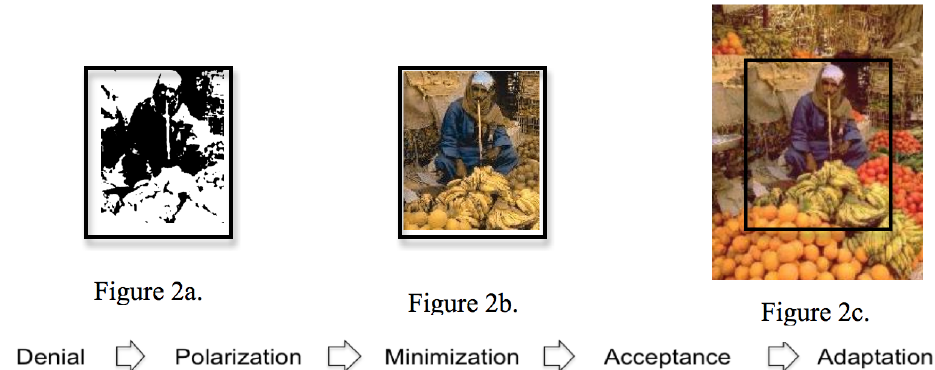
Figure 2. Intercultural orientations and developmental